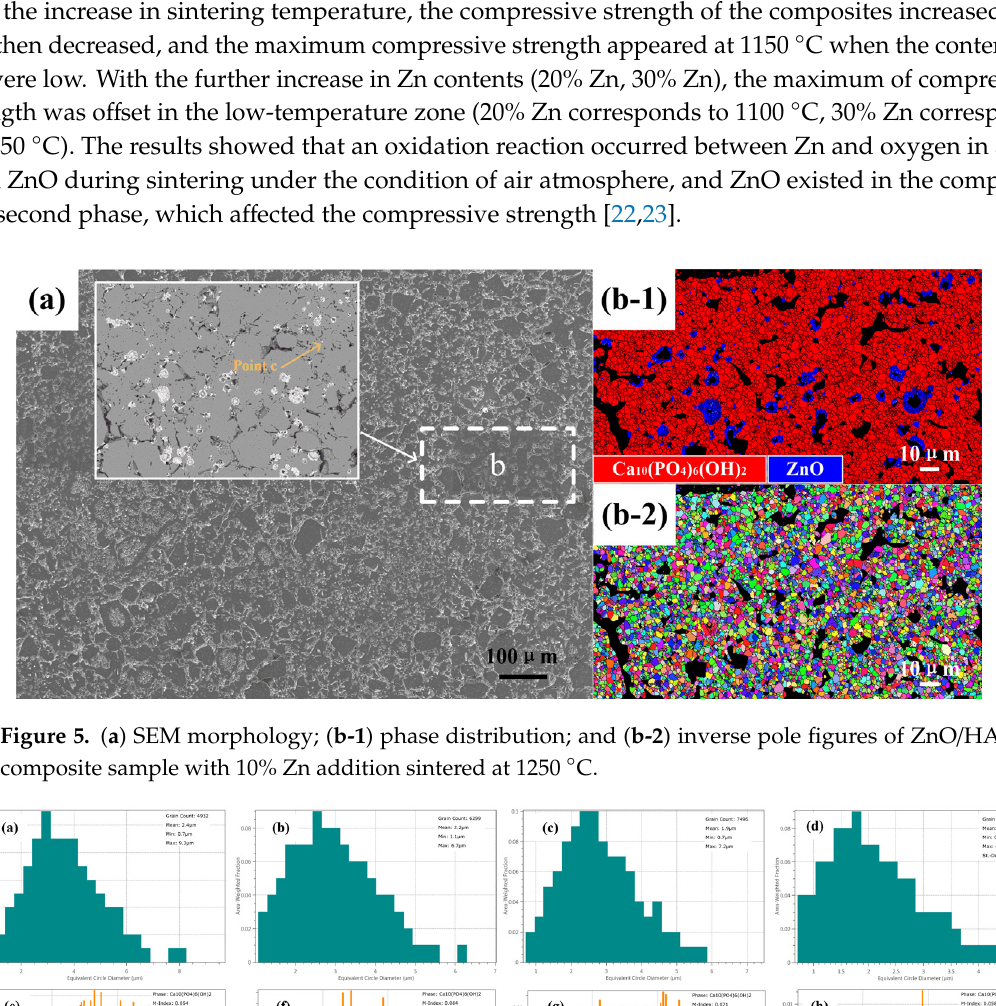
6 of 10 Figure 4. ( a ) SEM morphology; ( b-1 ) phase distribution; and ( b-2 ) inverse pole figures of pure HA sintered at 1250 °C. The SEM morphology of the ZnO/HA composite with 10% Zn addition sintered at 1250 °C for 2 h is shown in Figure 5a. It can be seen from the figure that a certain number of cavities with different shapes and sizes were distributed inside the materials. There was a certain number of cavities of nearly spherical shape also distributed, except for the cavities described in Figure 4a above. EBSD analysis on region b in Figure 5a has been shown as Figure 5b-1, and the phase distributions are superposed with BC, in which the red area represents the HA phase, the blue area represents the ZnO phase, and the black area corresponds to the cavities of different shapes and sizes in Figure 5a. The IPF of region b in Figure 5a is shown as Figure 5b-2, which is superimposed with GB and BC graphs, where different colors represent different crystal orientations. From the IPF, it can be preliminarily determined that the HA and ZnO grain orientation distribution was random and had